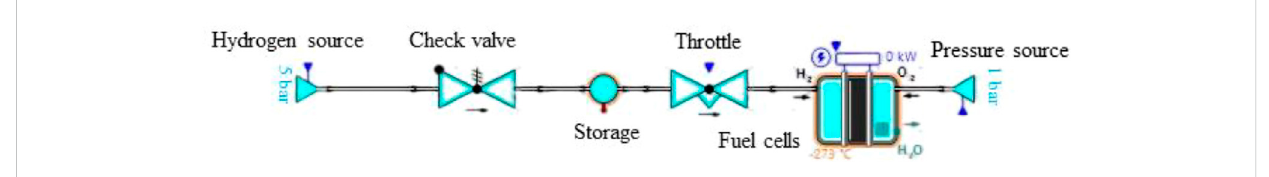
FIGURE 10 Simulation work process of hydrogen fuel cell system.